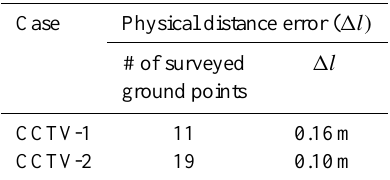
Table 3. Image rectification errors estimated using the surveyed ground points and the predicted locations of the ground points in the rectified domain. The physical distance errors at individual points were